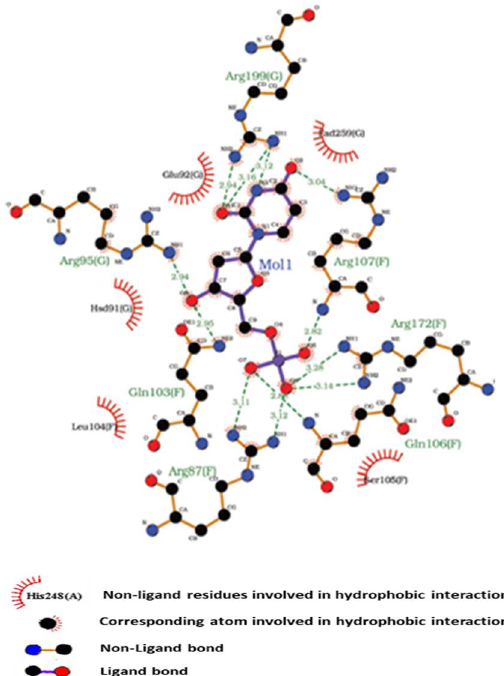
Figure 2. Hydrogen bond and hydrophobic interactions between the binding site of ThyX from Mycobacterium tuberculosis complex and natural substrate dUMP. The green dotted lines depict the hydrogen bonds whereas the other residues represent the hydrophobic interactions with the respective compounds.